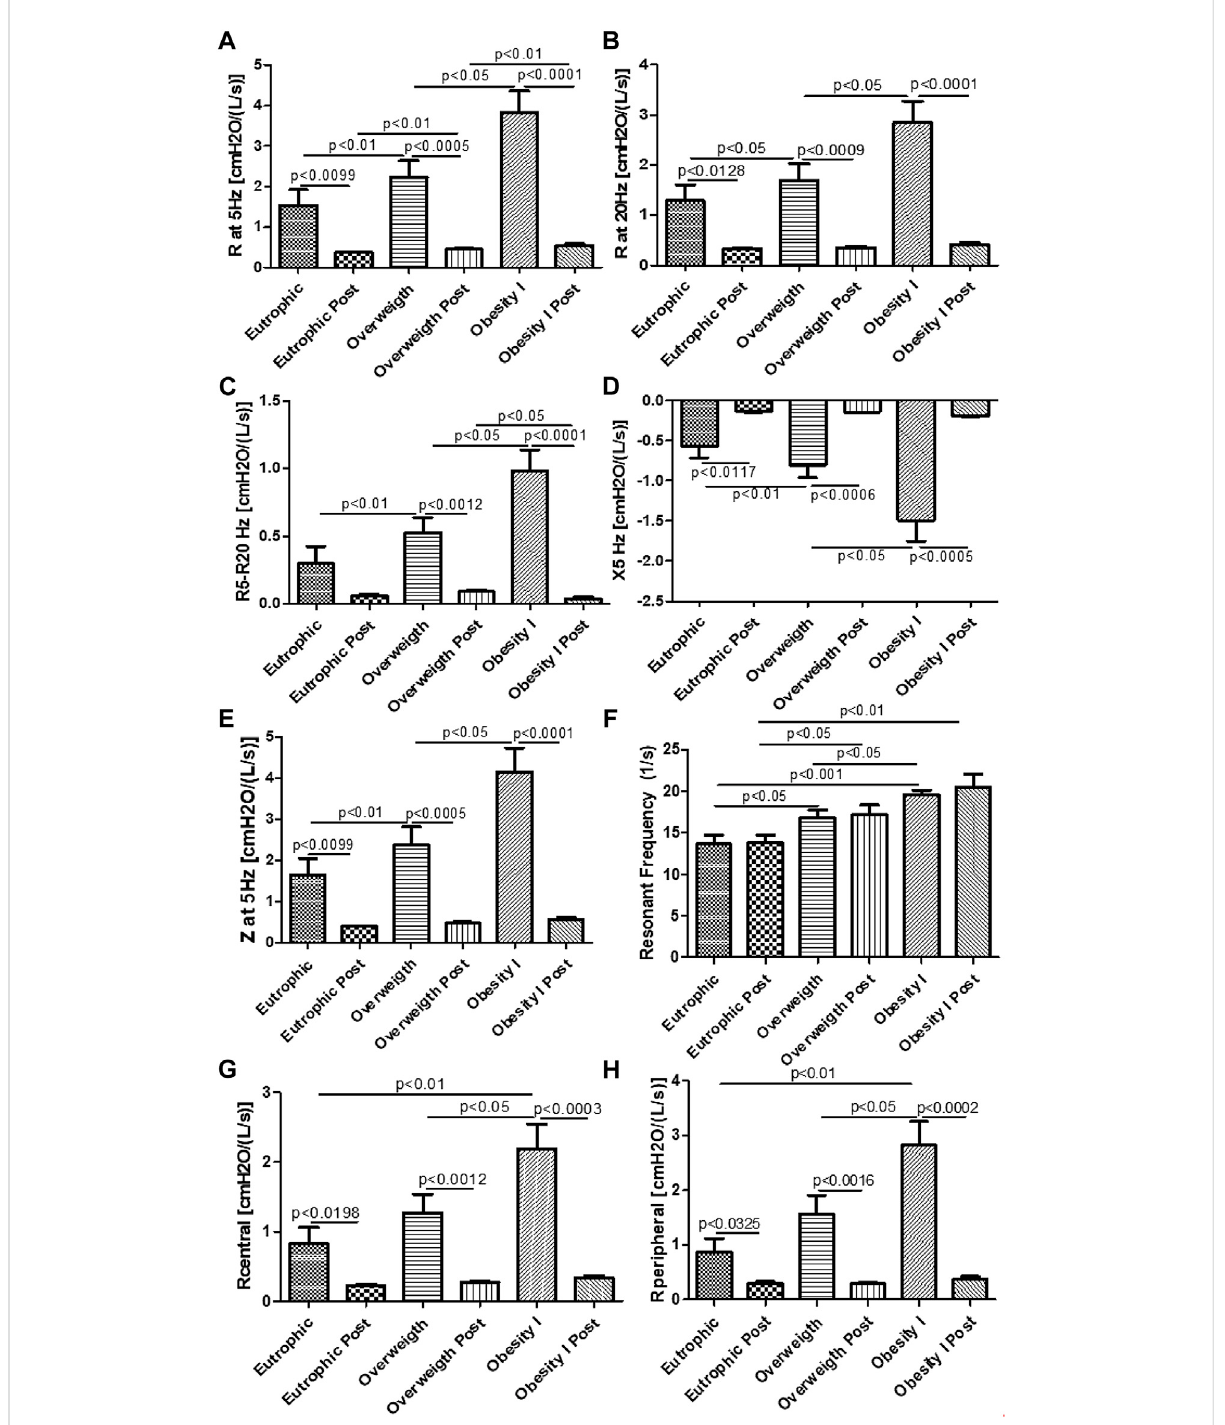
FIGURE 4 Effects of combined training on lung mechanics. Figure 4A shows the resistance of the whole respiratory system (R5 Hz); Figure 4B the resistance of the proximal airways (R20 Hz); Figure 4C the resistance of the distal airways (R5 – 20 Hz); Figure 4D the reactance of the respiratory systems(X5Hz);Figure4Etheimpedanceoftherespiratorysystems(Z5Hz);Figure4Ftheresonantfrequency(RFres);Figure4Gcentralresistanceof the respiratory system (RCentral); Figure 4H the peripheral resistance of the respiratory system (RPeripheral). Paired t -test was performed to compare the pre- and post-effects of rehabilitation (i.e., eutrophic non-obese pre x eutrophic non-obese post; overweight pre x overweight post; obesity I pre x obesity I post). A p < 0.05 was considered statistically signi fi cant. These data presented parametric distribution and were additionally evaluated using one way ANOVA followed by the Newman – Keuls test for multiple comparisons among the